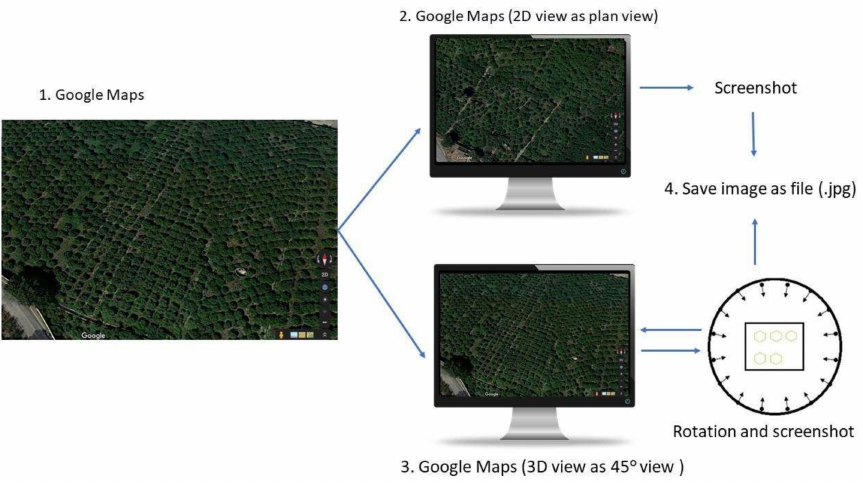
Figure 11. Methodology chart for the proposed method using Google Maps (GM).